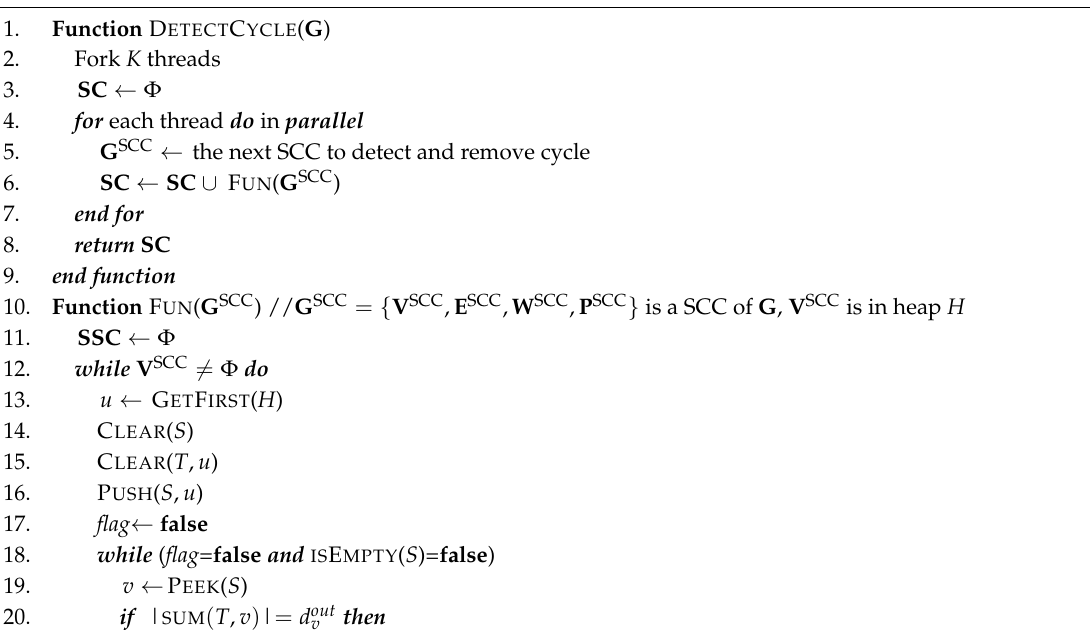
Algorithm 4. Detect Cycles of a Weighted Directed